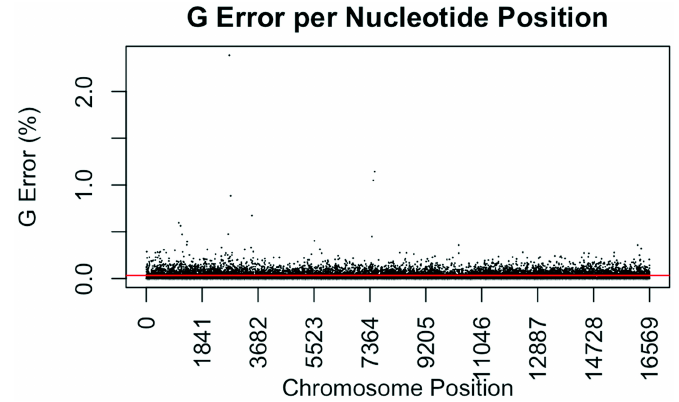
Figure 2. Substitution error rate for C (cytidine) nucleotides per nucleotide position across the mtgenome. The error rate was calculated as described in Figure 1. The red line indicates the average C error (0.0565%) for all nucleotide positions. Genes 2018 , 9 , x FOR PEER REVIEW